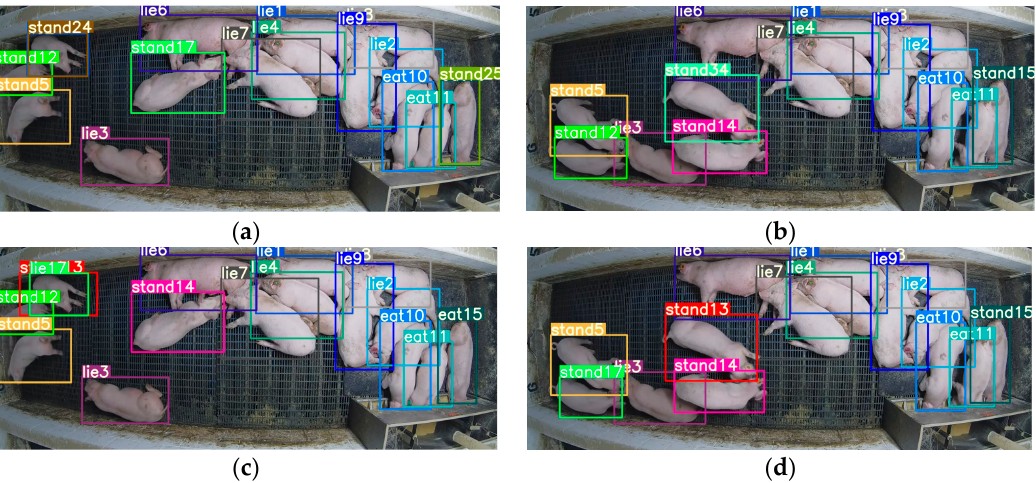
Figure 8. Tracking results of original and improved DeepSORT based on YOLOX-S model of Pig03. ( a ) Frame 50, original DeepSORT; ( b ) Frame 150, original DeepSORT; ( c ) Frame 50, improved DeepSORT; and ( d ) Frame 150, improved DeepSORT.